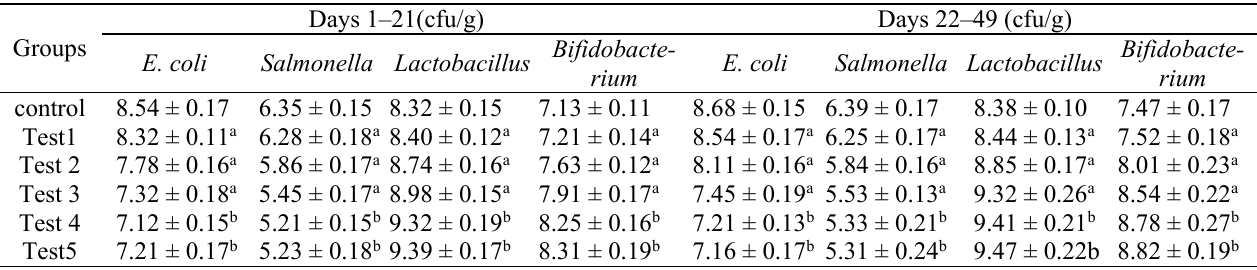
Effects of CB on cecal microfloraof broilers (n = 6)